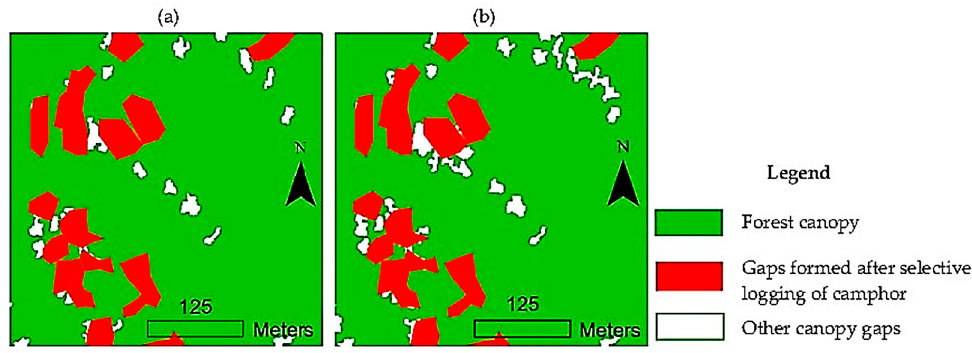
Figure 5. Subset classification results of image block D based on the multivariate texture classification (853-RGB) based on MLBP/MHOM distribution—( a ) RF and ( b ) SVM.